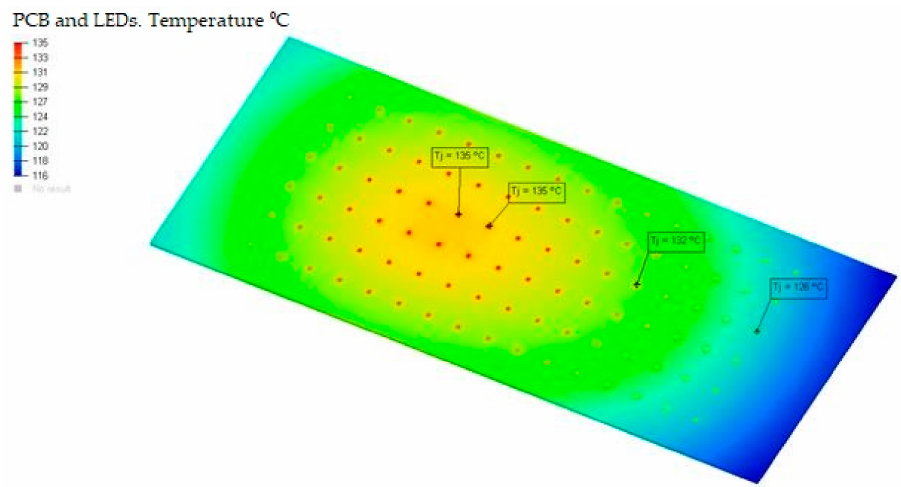
Figure 23. Summary of the joining temperatures of LEDs during the simulation at ambient tempera- ture of 40 ◦ C. Source: our own elaboration.